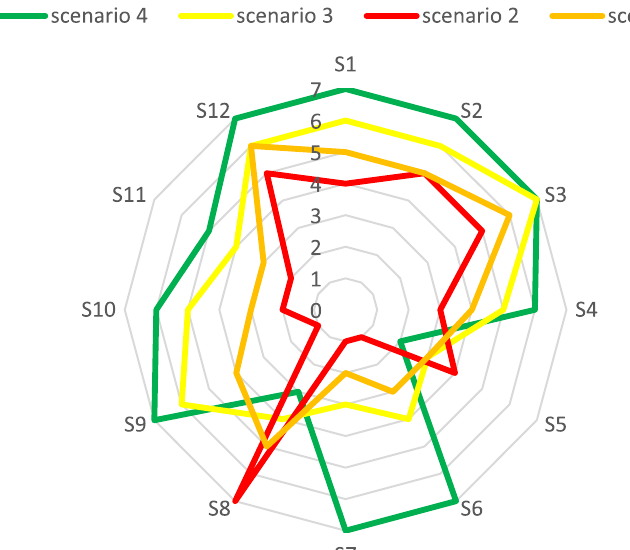
Fig. 5 Radar diagram of robustness of preexisting strategic objectives within